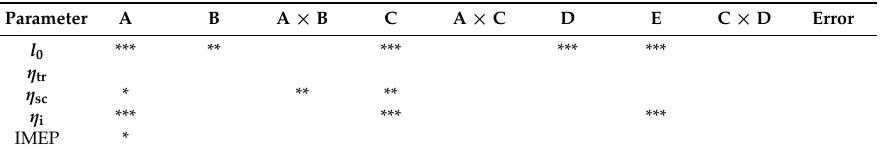
Table 5. Significance